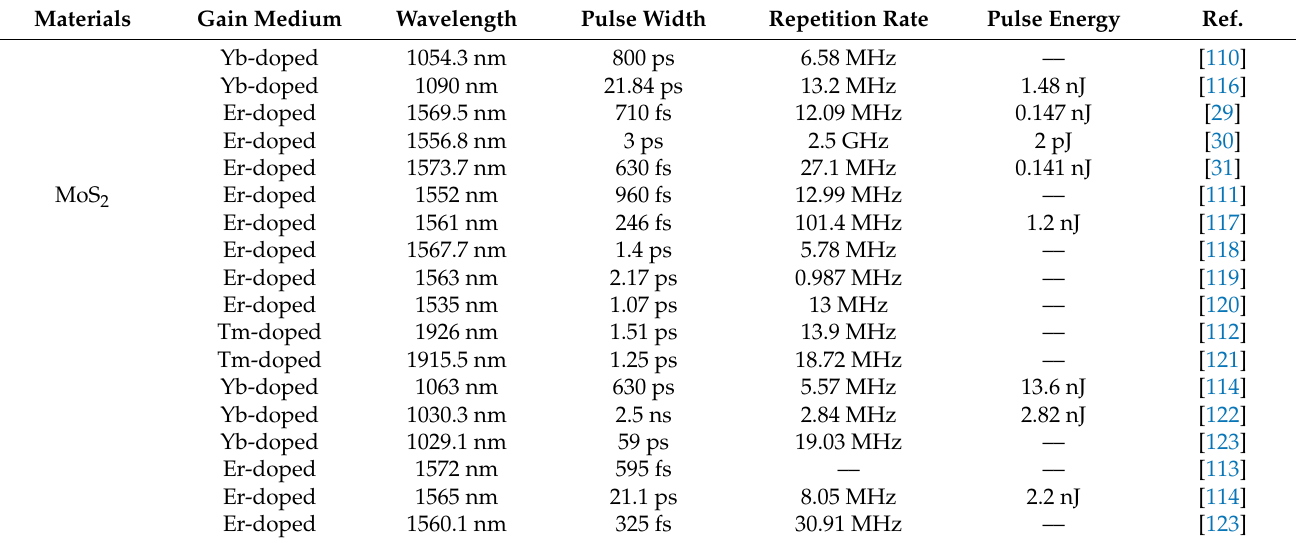
Figure 11. ( a ) Output spectra at eight representative wavelengths, continuous tuning from 1535 nm to 1565 nm. ( b ) Autocorrelation traces of the laser output at five representative wavelengths within the tunable operating range. Reproduced from ref. [111]. Springer Nature, 2015. Table 4. Summary of passively mode-locked fiber lasers with TMD materials.